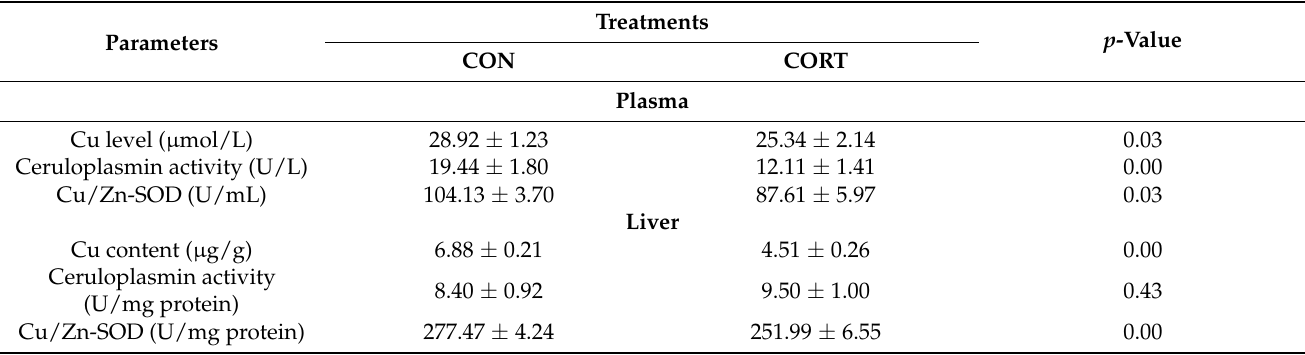
Table 1. Corticosterone exposure disturbs plasma and hepatic copper-metabolism-related parameters in